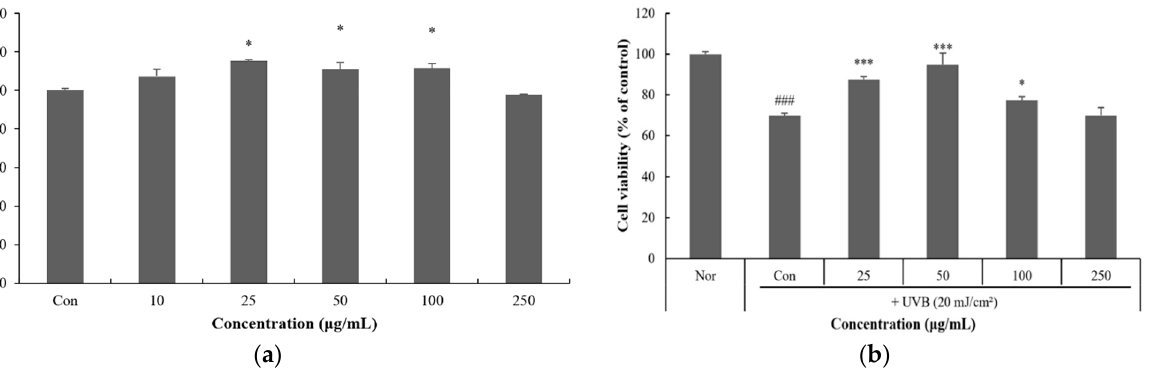
Figure 4. ( a ) Effect of P. thunbergiana L. EtOAc fraction on cell viability in HaCaT cells. Cells were treated with 10–1000 µ g/mL P. thunbergiana L. EtOAc fraction. ( b ) Effect of P. thunbergiana L. EtOAc fraction on cell viability in UVB-irradiated (20 mJ/cm 2 ) HaCaT cells (Nor: normal control; Con: control) The results are expressed as the mean ± SD from three independent experiments. ### p < 0.001 compared with the normal control; * p < 0.05 and *** p < 0.001 compared with the